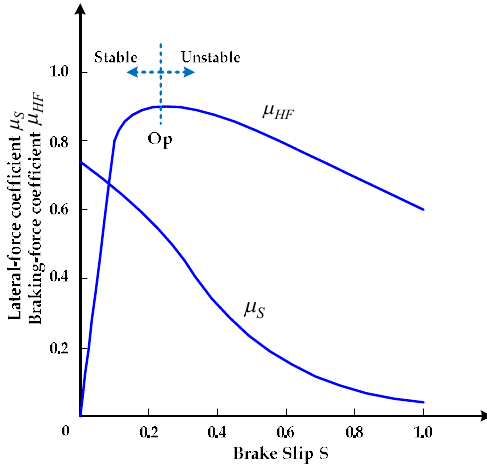
Figure 2. Relationship between wheels and pavement.